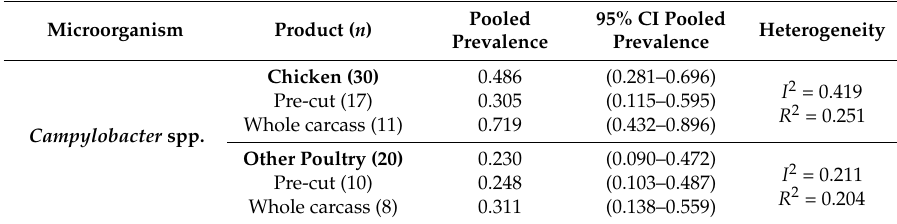
Table 1. Meta-analysis of the incidence of pathogens in poultry meat by type of cut. Heterogeneity analysis comprises between-study variability to total variability ratio ( I 2 ) and proportion of between-study variability explained by type of meat cut ( R 2